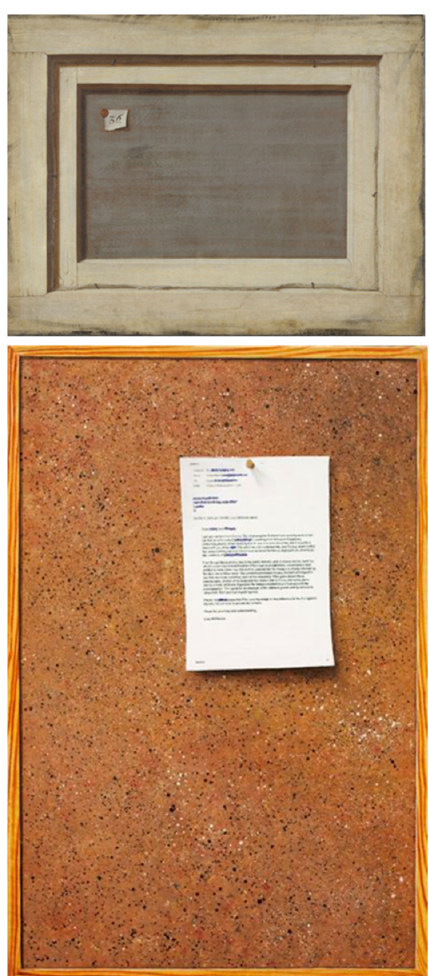
Figure 7. ( Top ) Trompe l’oeil. The Reverse of a Framed Painting (Gijsbrechts 1670). ( Bottom ) Quodlibet XXVI (self-portrait ) (McKenzie 2013).